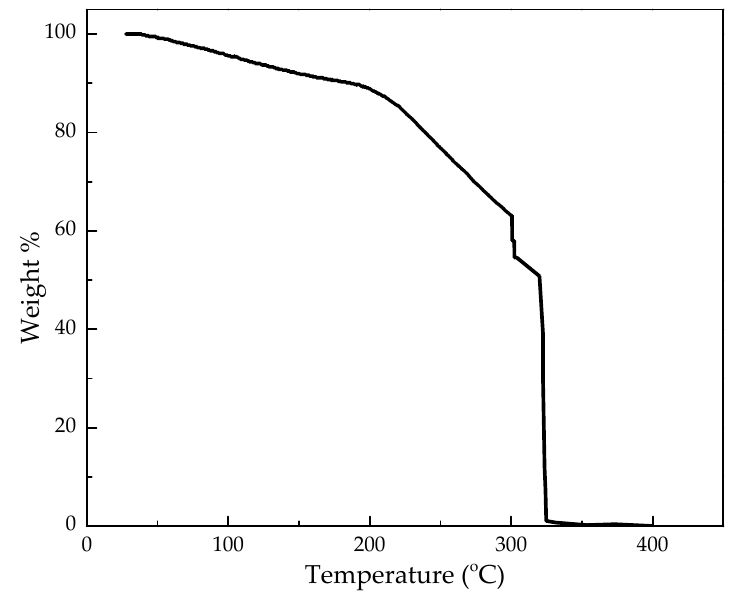
Figure 13. TGA profile of DES-3.